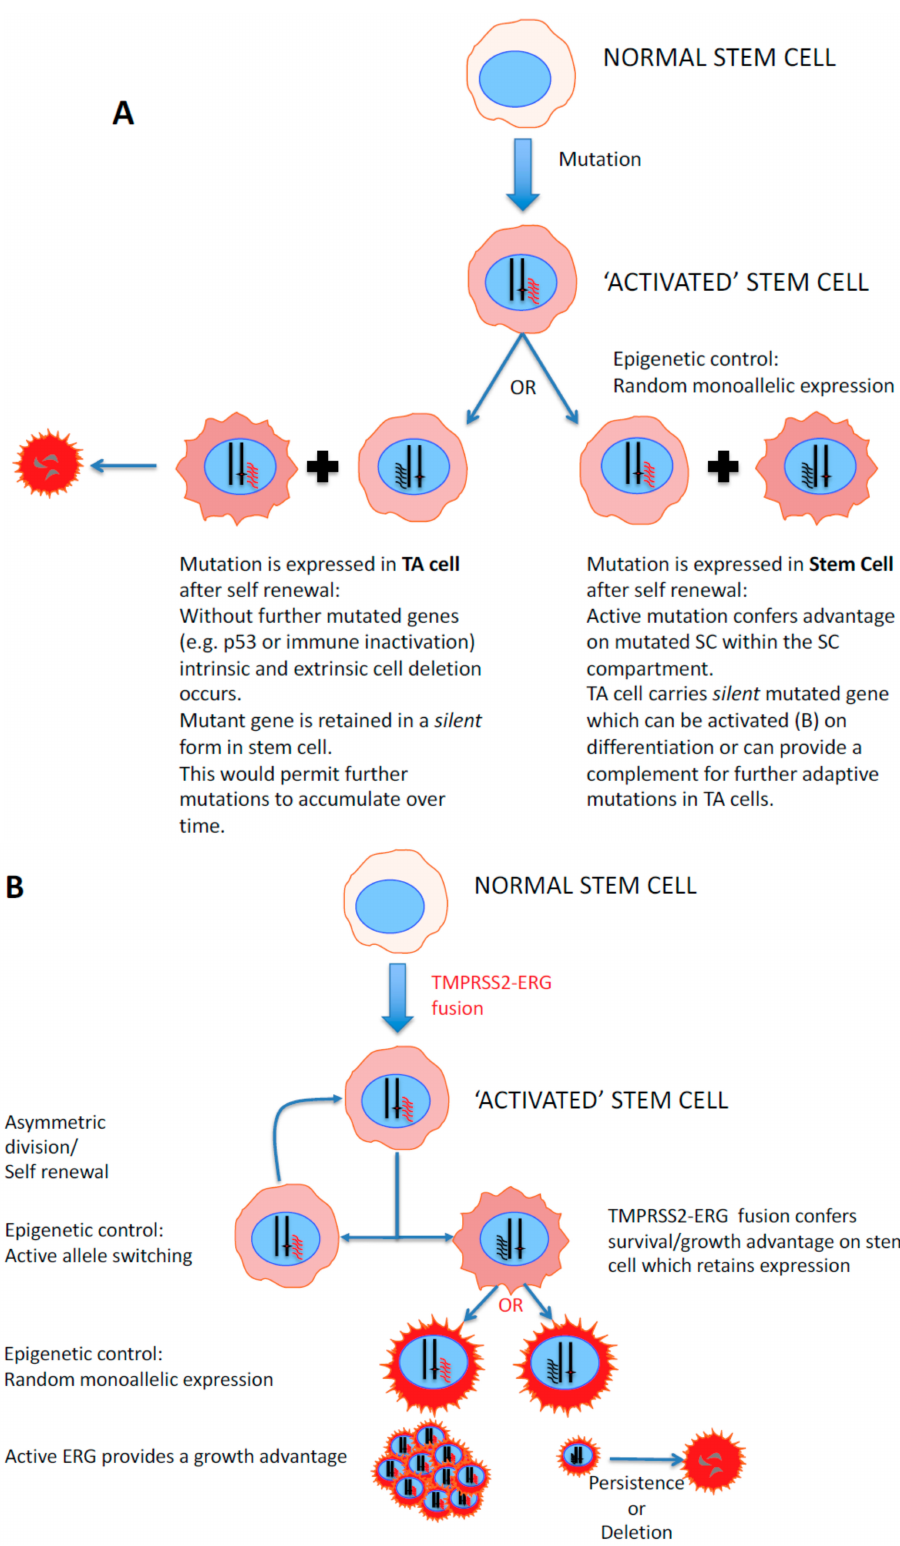
Figure 5. Epigenetic control of gene silencing and clonal deletion in prostate cancer development. ( A ) Activating mutations (or epigenetic controls) in the stem cell are either neutral (left) or confer a selective advantage for the SC. As shown on the left panel, in the absence of other changes the self-renewal results in an SC which does not express the activating copy, but rather the wild-type